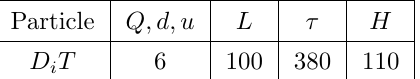
Table 9. Thermal mass contributions for the